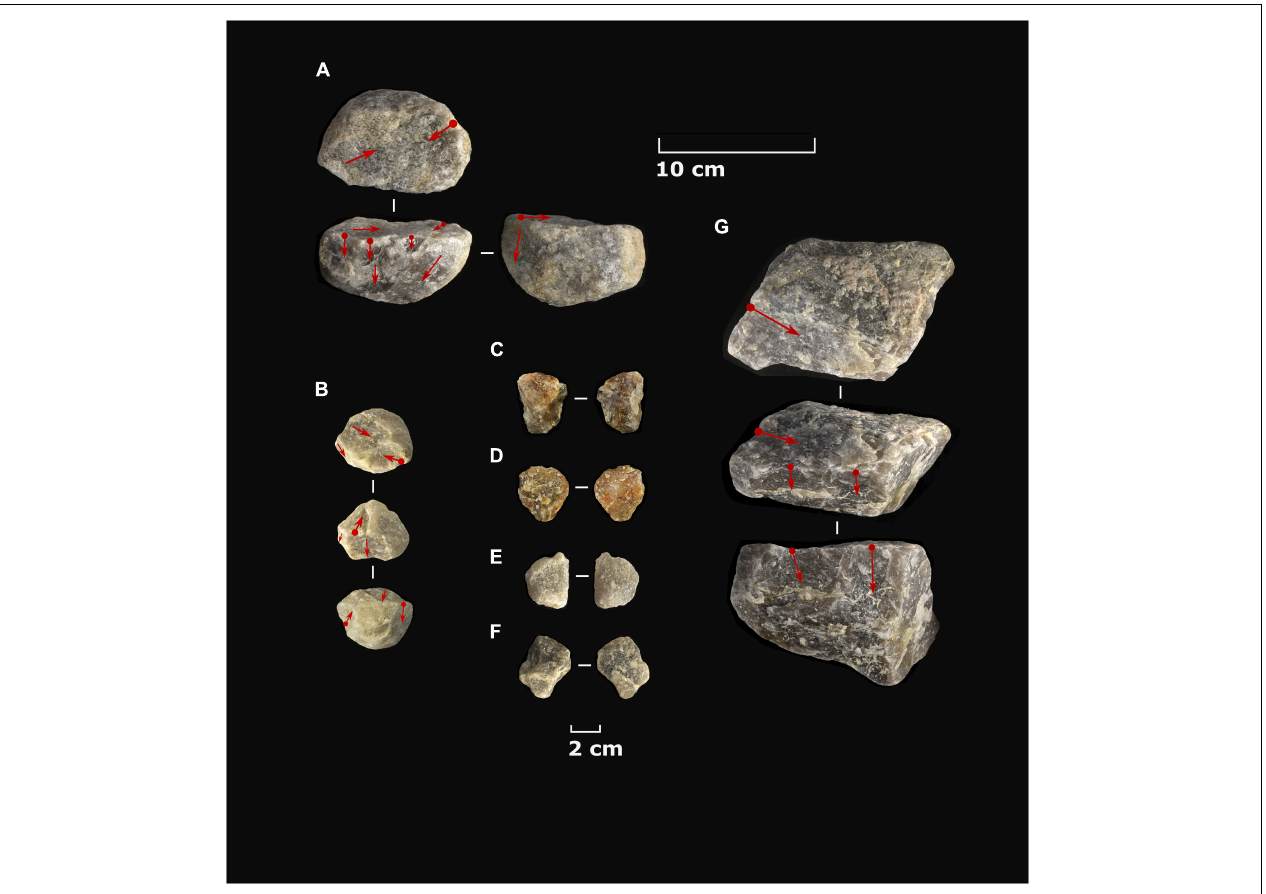
FIGURE 5 | Selection of stone tools from Phase IV. (A) Quartzite bifacial orthogonal core with technical schemes. (B) Quartzite multipolar multifacial core with technical schemes. (C–F) Quartzite flakes. (G) Quartzite unipolar longitudinal core with technical schemes. Red arrows indicate the directions of flake’s removals.